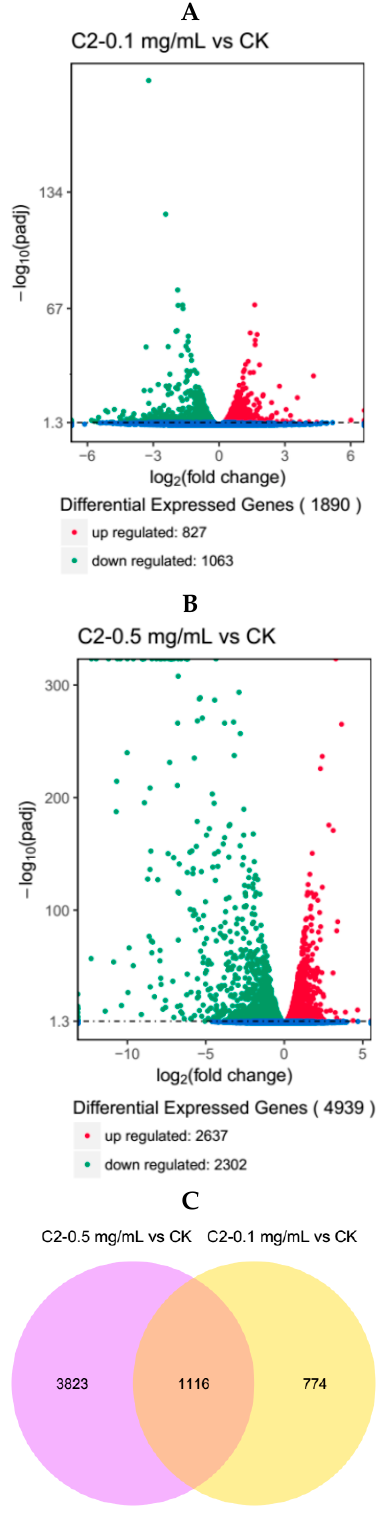
Figure 2. Bioinformatic analysis of differentially expressed genes (DEGs). Volcanic figures of DEGs in the ( A ) C2-0.1 mg/mL vs. CK and ( B ) C2-0.5 mg/mL vs. CK comparisons; ( C ) Venn diagram showing the number of genes expressed in the two groups.